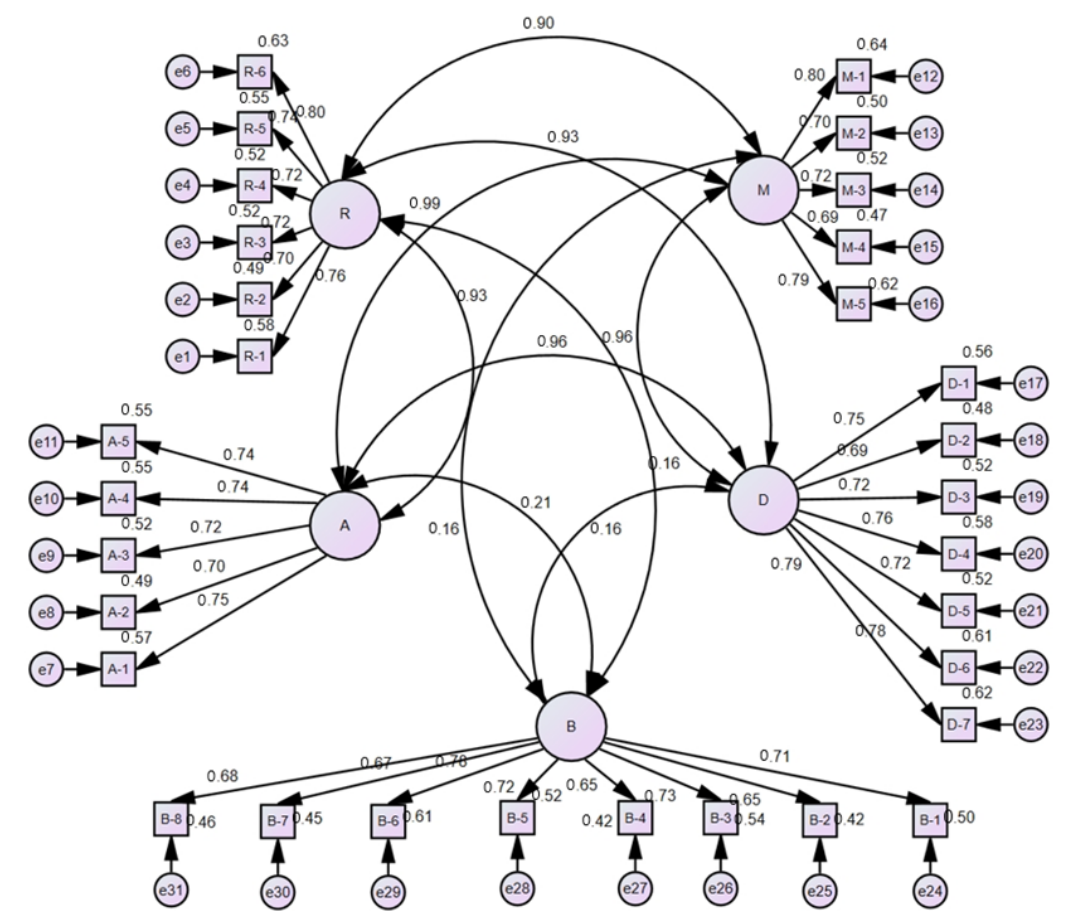
Figure 2. Structural equation model. Note: R = Regional economic benefit; A = Effects related to increased use in air transportation; M = Effects related to increased exchange with other regions; D = Effects related to regional development, B = Dis-benefit to the region.